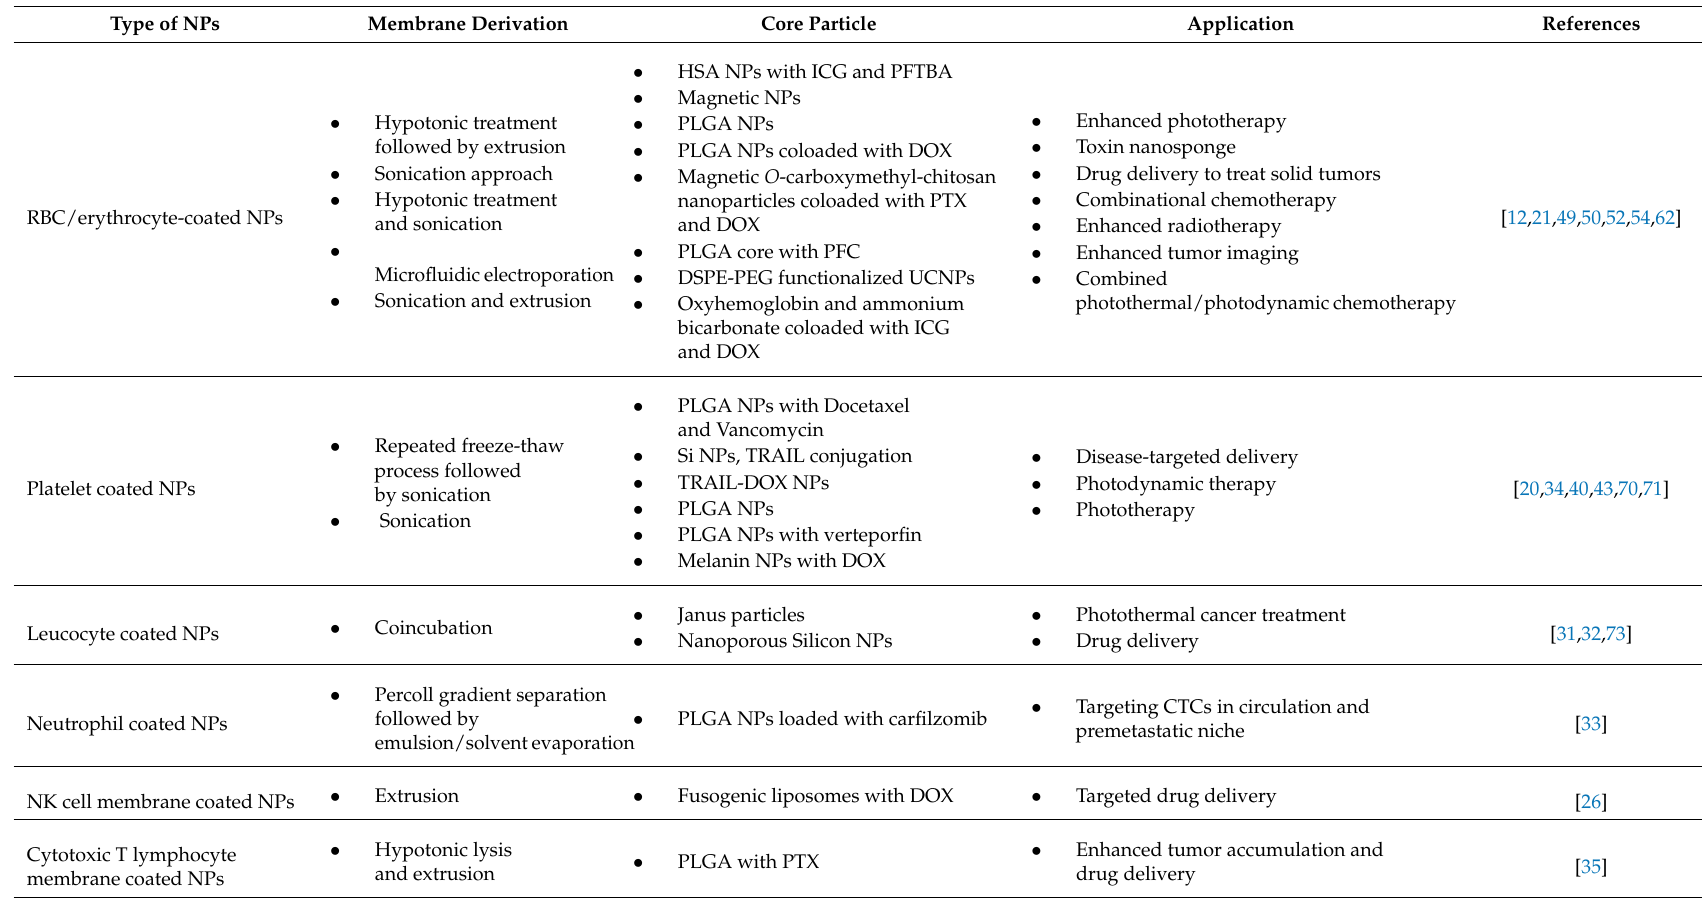
Table 2. Application of various membrane-coated